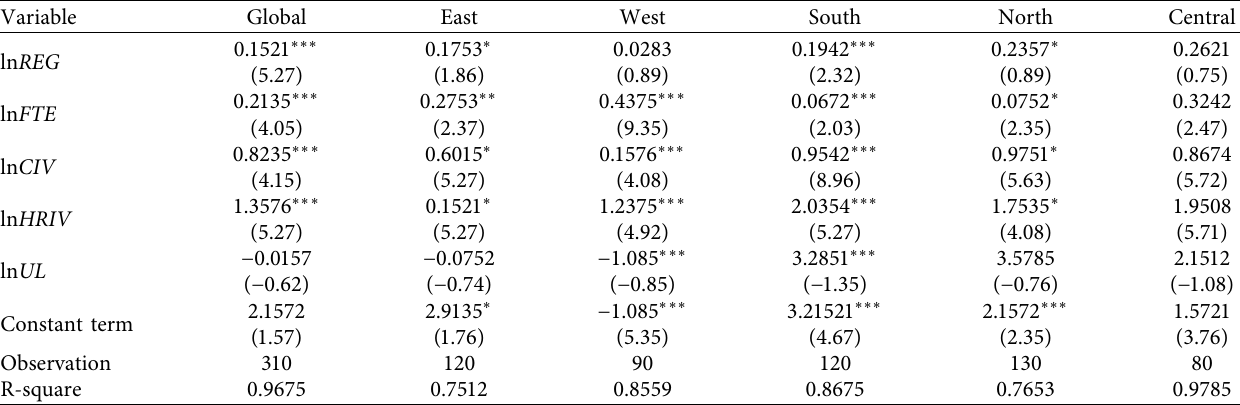
Table 8: Regression